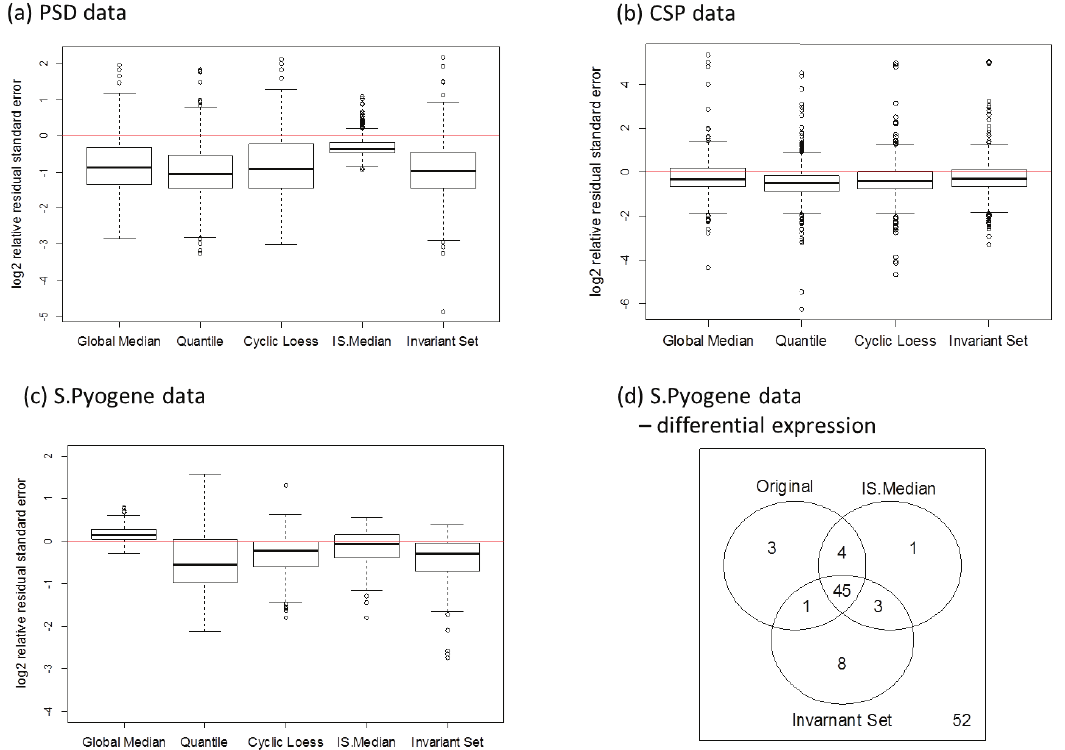
Figure 9. Differences between the within-group deviation between normalized and original data for ( a ) PSD, ( b ) CSP, and ( c ) S. Pyogene data along with the two-group comparison result at 5% false discovery rate ( d